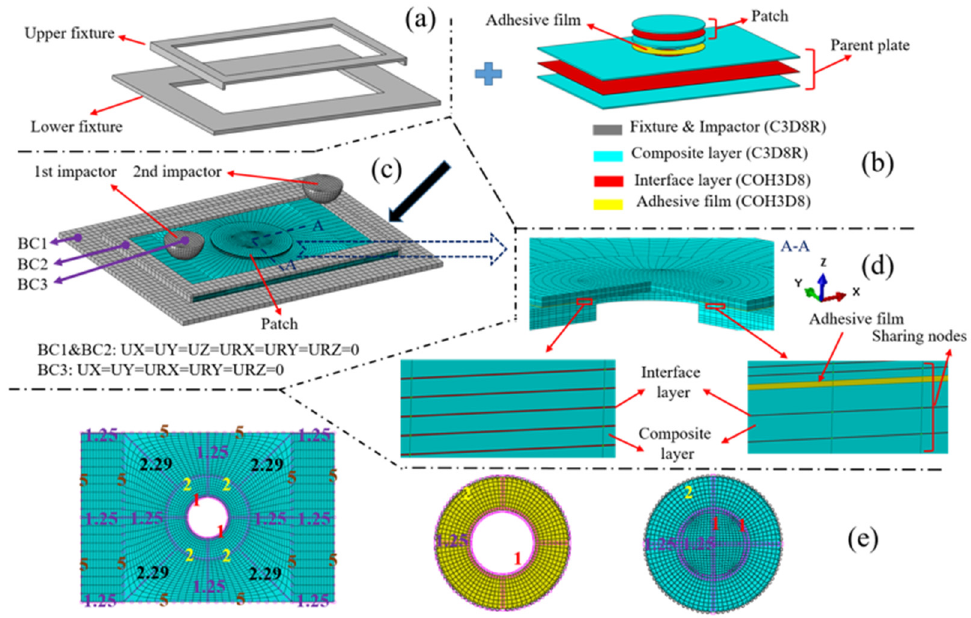
Figure 5. The FEM for double impacts: ( a ) fixtures, ( b ) components of the repaired specimen, ( c ) complete model and boundary conditions BC1-BC3, ( d ) section A-A with partial enlarged drawings in it and ( e ) seeds distribution for the edges of the parent plate, adhesive film and patch. 1-one seed per 1 mm, 2-one seed per 2 mm, 5-one seed per 5 mm.